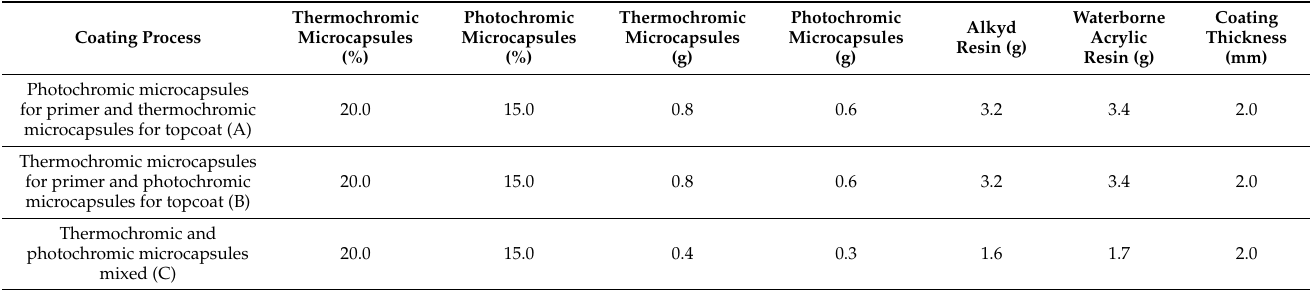
Figure 1. Schematic diagram of preparation method. Table 2. Experimental material